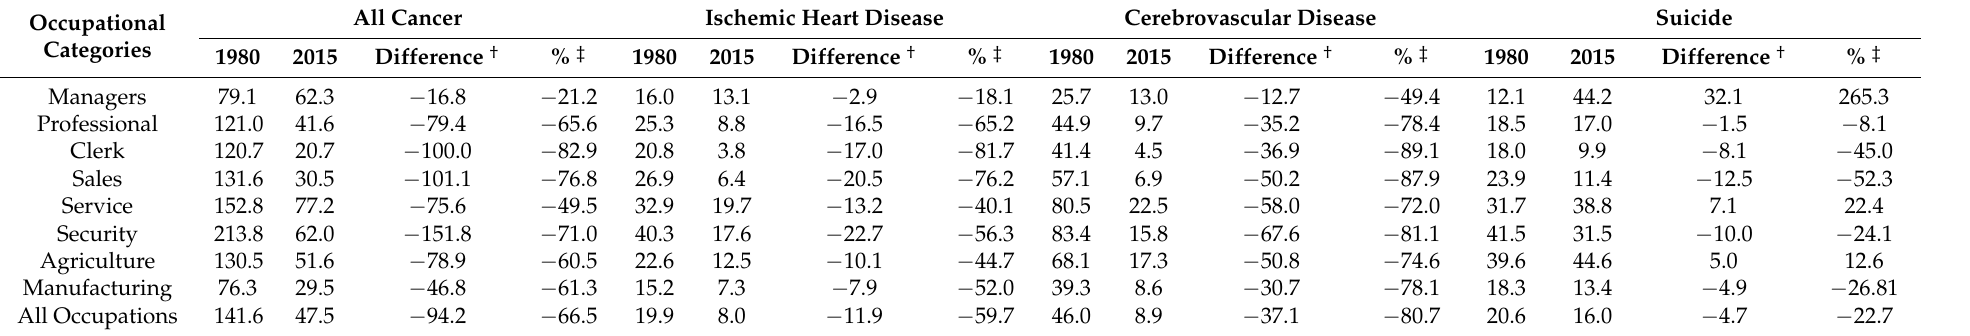
Table 3. Age-standardised absolute and relative differences in mortality rates between 1980 and 2015, by